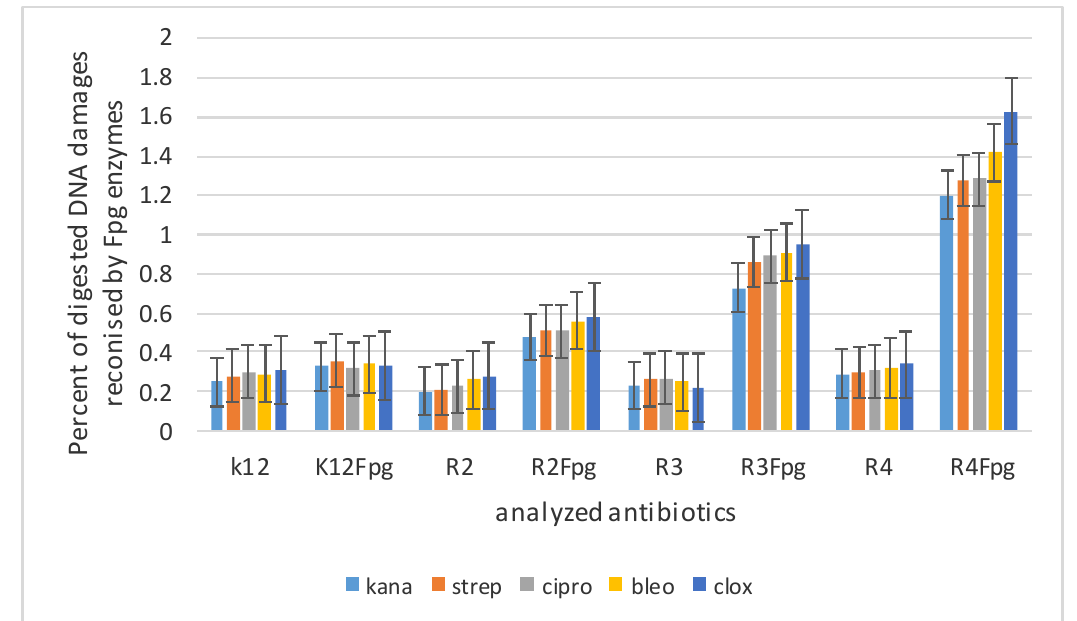
Figure 8. Percentage of bacterial DNA recognized by Fpg enzyme in model bacterial strains after kanamycine, sterpromycine, ciprofloxacin, bleomycine and cloxsacilline treatment. The compounds were statistically significant at p < 0.05.